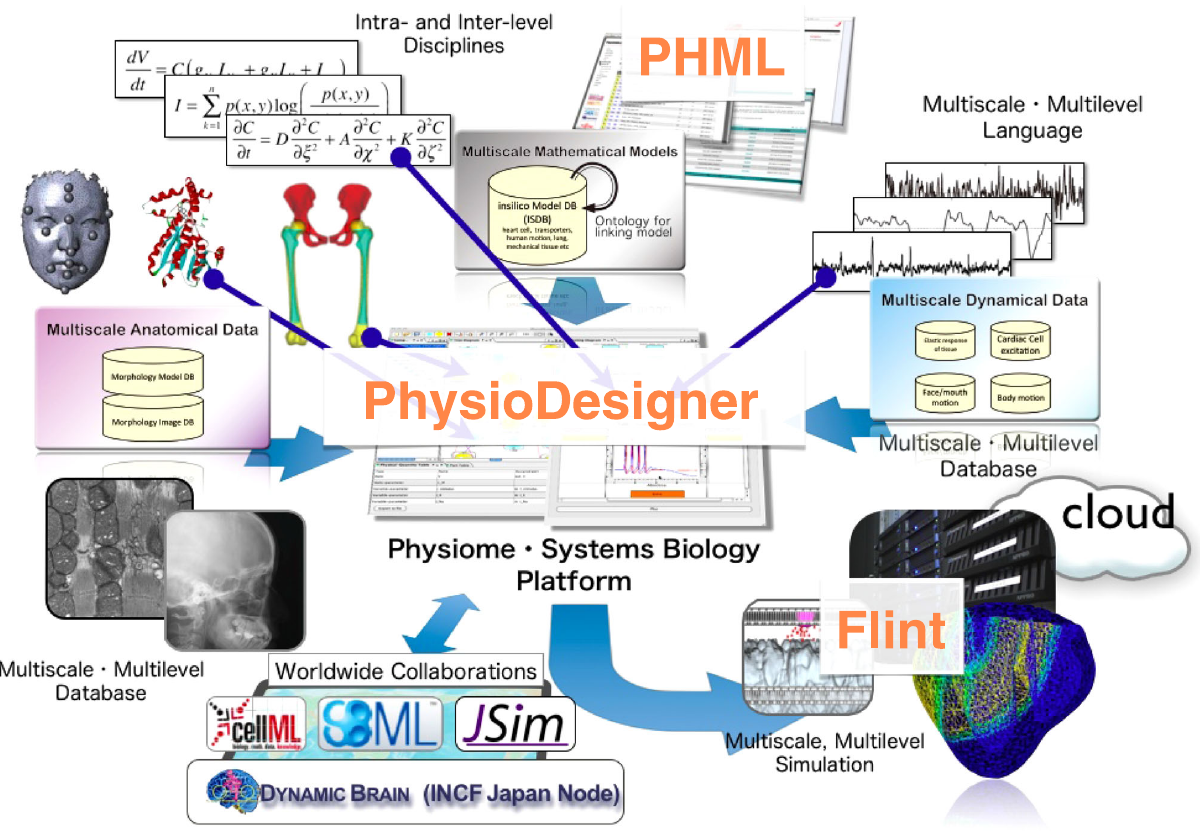
Fig. 2 Information fl ow with a focus on PhysioDesigne. This illustration is reproduced and reprinted with permission from the author and from the website Physiome.jp